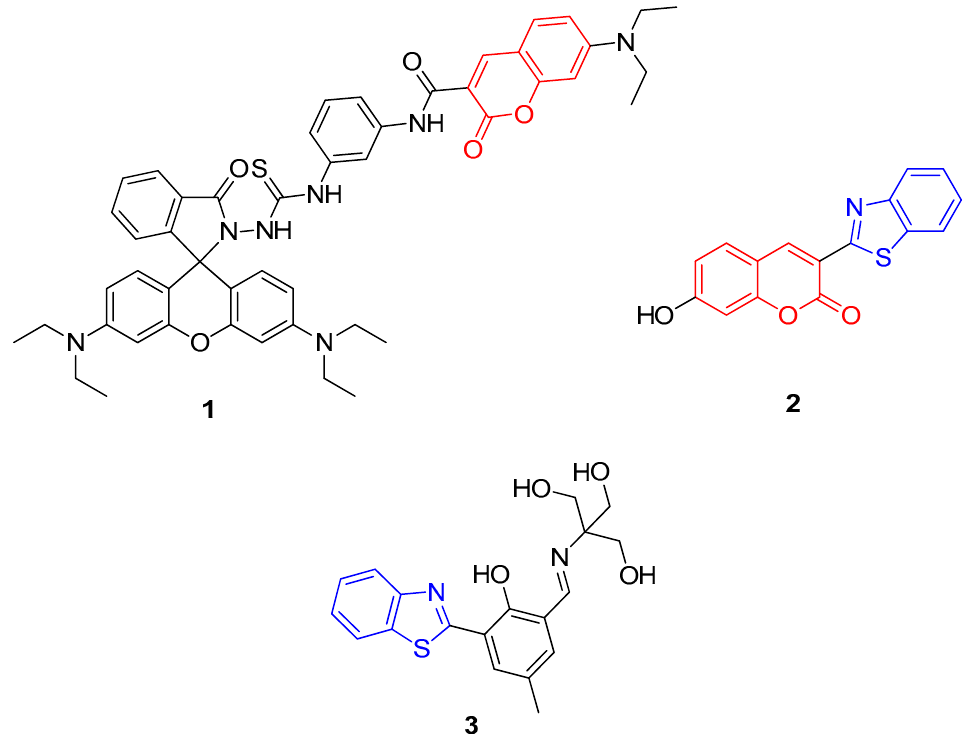
Figure 1. Chemical structures of coumarin-based and benzothiazole-based fluorescent probes.